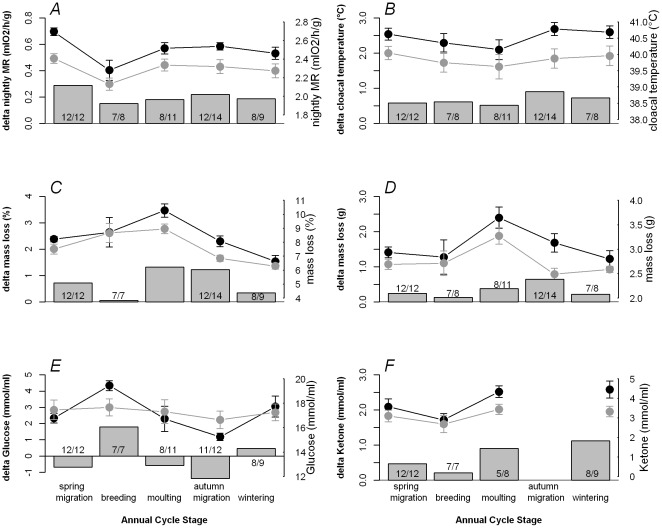
Effect of LPS injection on a) mass-specific nightly metabolic rate, b) body temperature, c) relative mass loss during the night, d) absolute mass loss during the night, e) glucose concentration and f) ketone concentration of skylarks after 13 hours.Experimental birds were injected with LPS; control birds were un-injected. Black symbols represent experimental birds (LPS-injected), grey symbols control birds (un-injected). Bars represent the difference between these two groups. Means and standard errors are shown; numbers in bars represent sample sizes per group (control/experimental). The graphs show raw data without correcting for sex effects. There was never a significant treatment* annual cycle stage interaction (all P>0.084). See Table 1 for statistics.